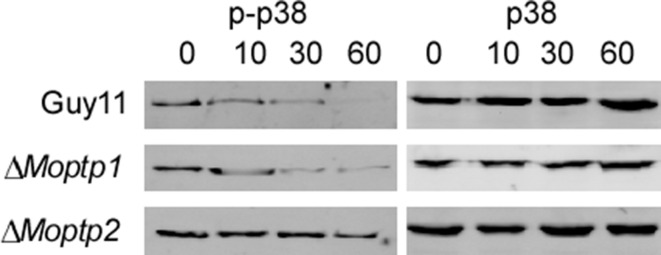
MoOsm1 phosphorylation levels in ∆Moptp1/2 mutants under oxidative stress.Immunoblots were performed with total proteins from Guy11, ΔMoptp1, and ΔMoptp2 mutant strains without or with 5 mM H2O2 for 10, 30, and 60 min. The MoOsm1 phosphorylation level was detected using the P-P38 antibody. MoOsm1 was detected by the p38 antibody as control.